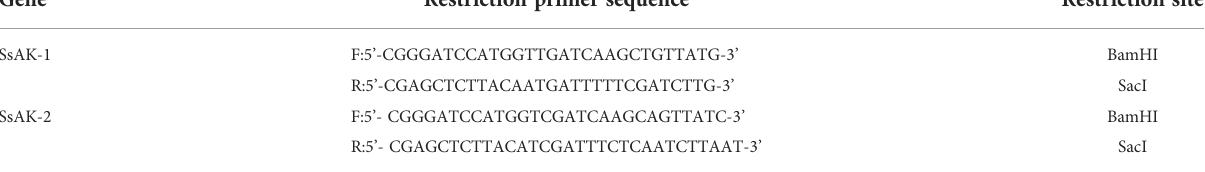
TABLE 1 Restriction primer sequences of the SsAK-1 and SsAK-2